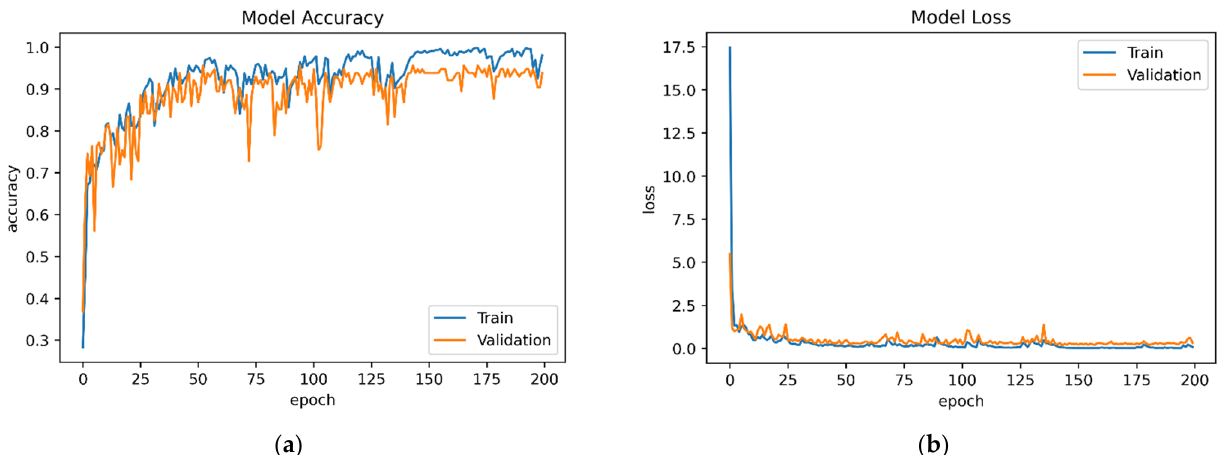
Figure 23. Deep Learning Evaluation Using DS2: ( a ) TModel2 Accuracy and ( b ) TModel2 Loss. Figure 24 plots the confusion matrices of the TModel1 and TModel2 deep learning models used on a test dataset that the trained model was not exposed to. For TModel1, the highest number of true positives were obtained for the Floor (20) and Ascending Stairs (18), followed by Wall and High Obstacle (15), Descending Stairs (9), Descending Step (5),